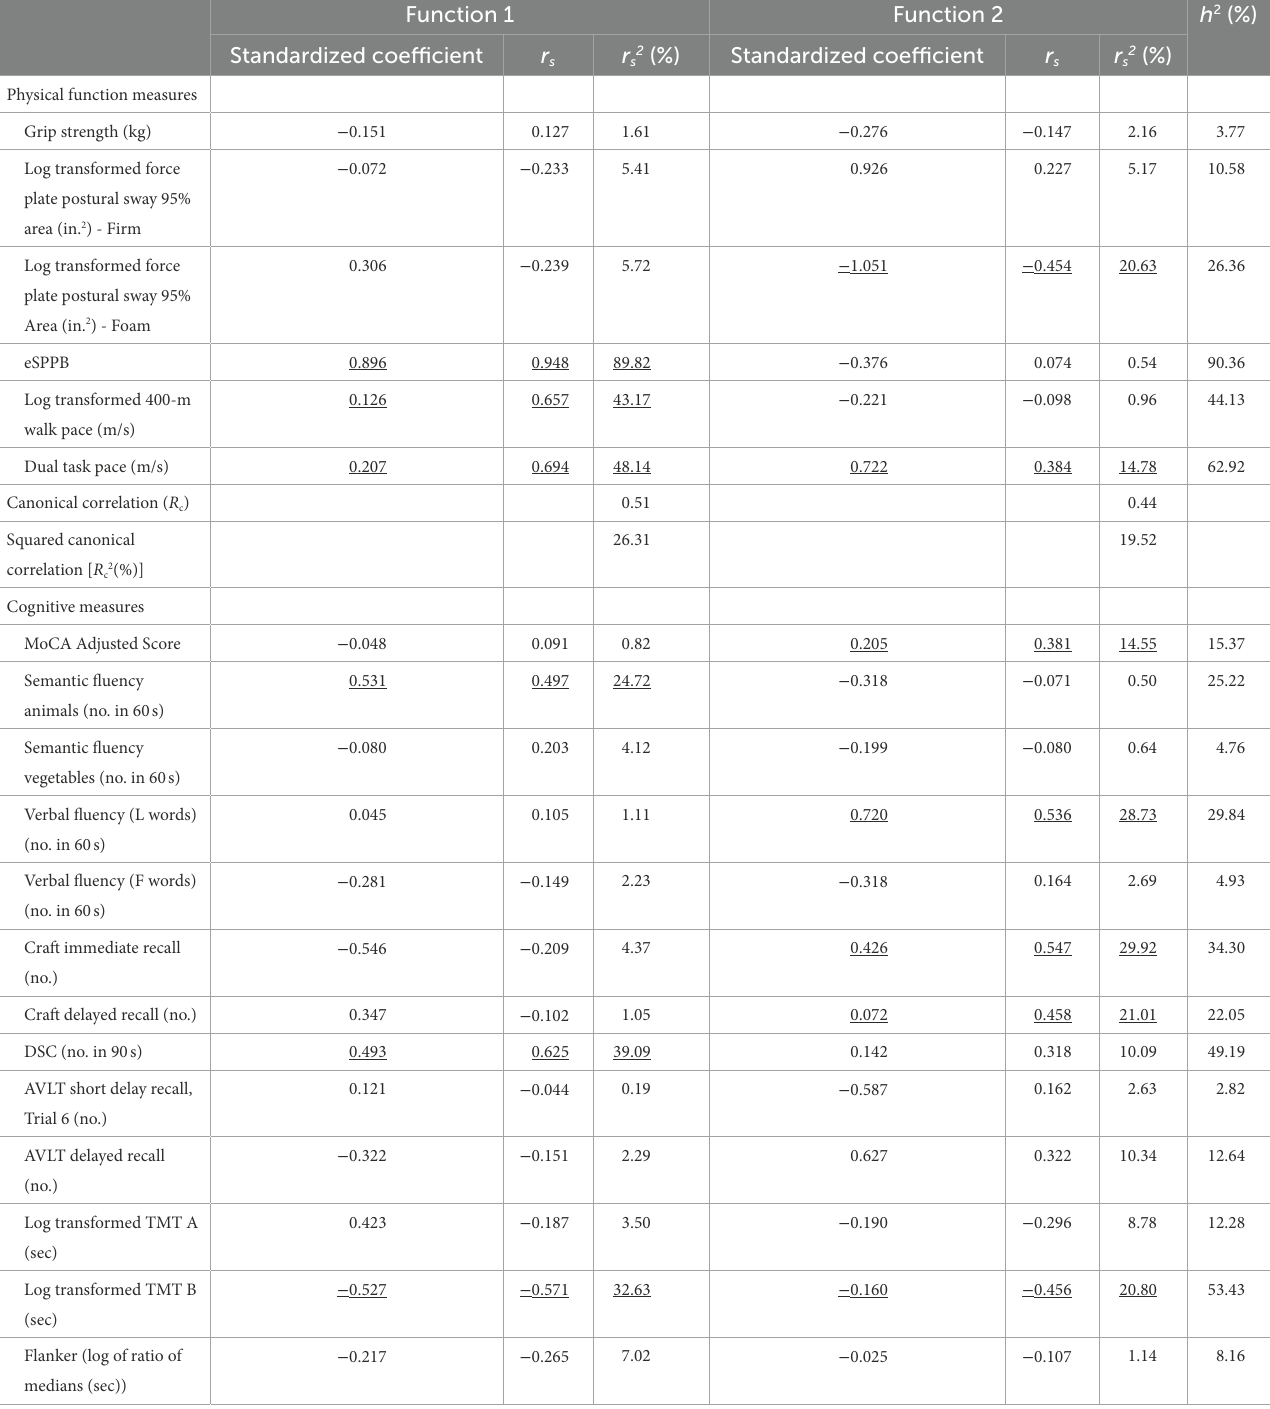
TABLE 2 Canonical correlation analysis results adjusted for sex ( n =